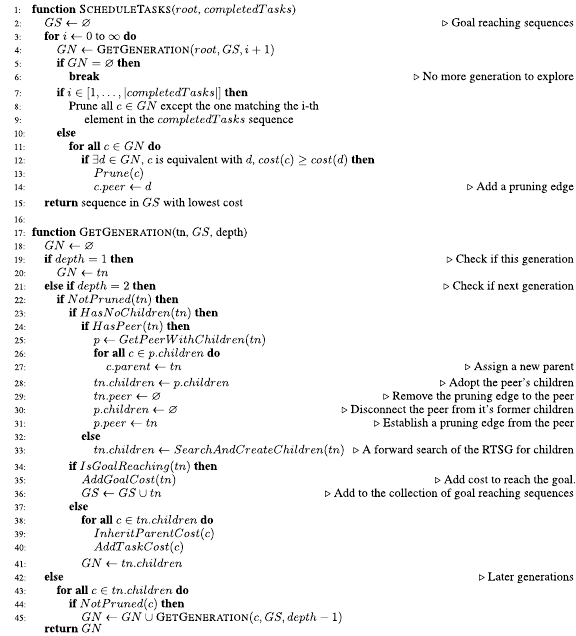
Algorithm 1: B&B and